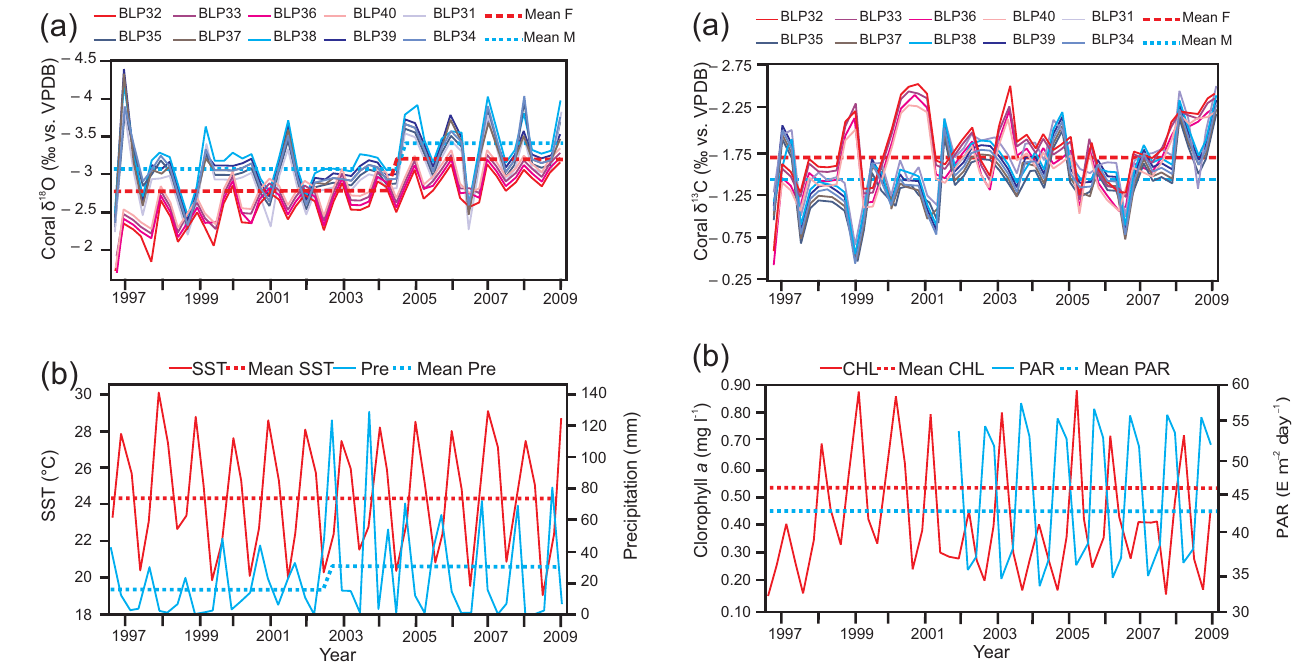
Figure 3. (a) Seasonal variation in δ 18 O composition (VPDB) from Porites panamensis coral colonies along the major growth axis. Blue lines represent male colonies; red lines represent female colonies; red dotted line female colonies’ regime mean; blue dotted line, male colonies’ regime mean. (b) Satellite sea surface temper- ature and precipitation (1997–2009) records. Sea surface tempera- ture (red line; ◦ C), mean sea surface temperature (dotted red line; ◦ C), precipitation (blue line;mm), mean precipitation (dotted blue line;mm). Note the regime shift in the precipitation mean in 2003.